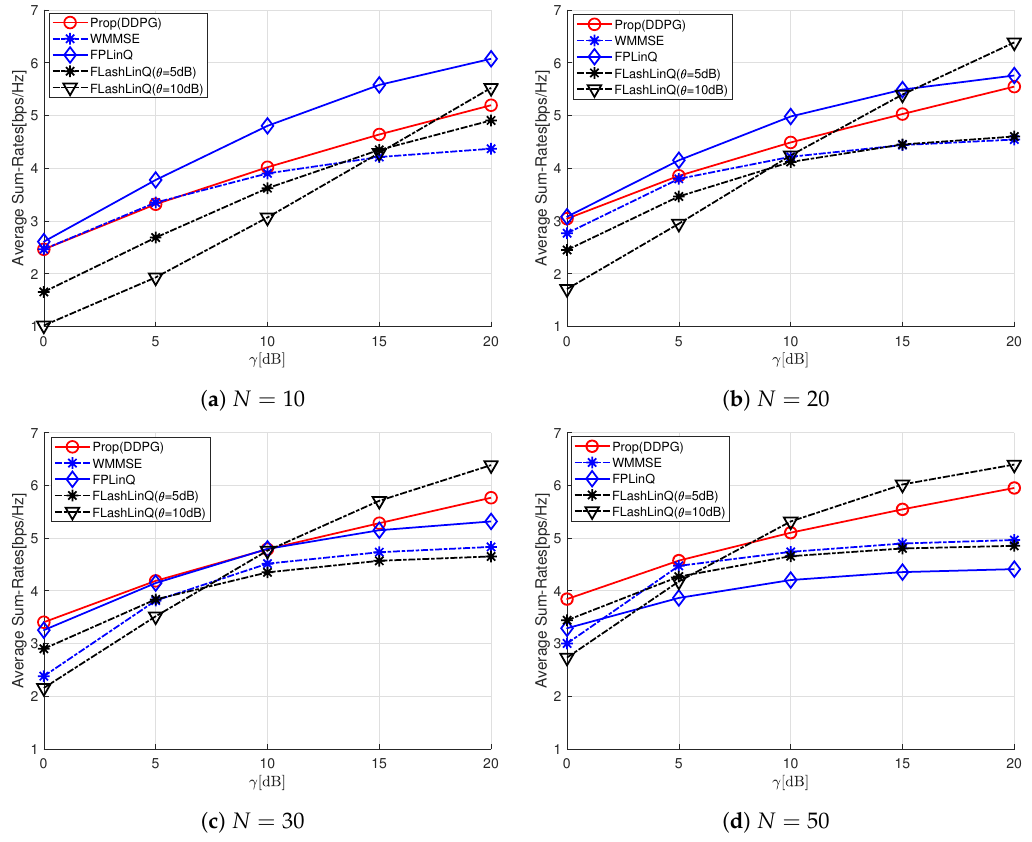
Figure 3. Average sum-rate for various γ and N